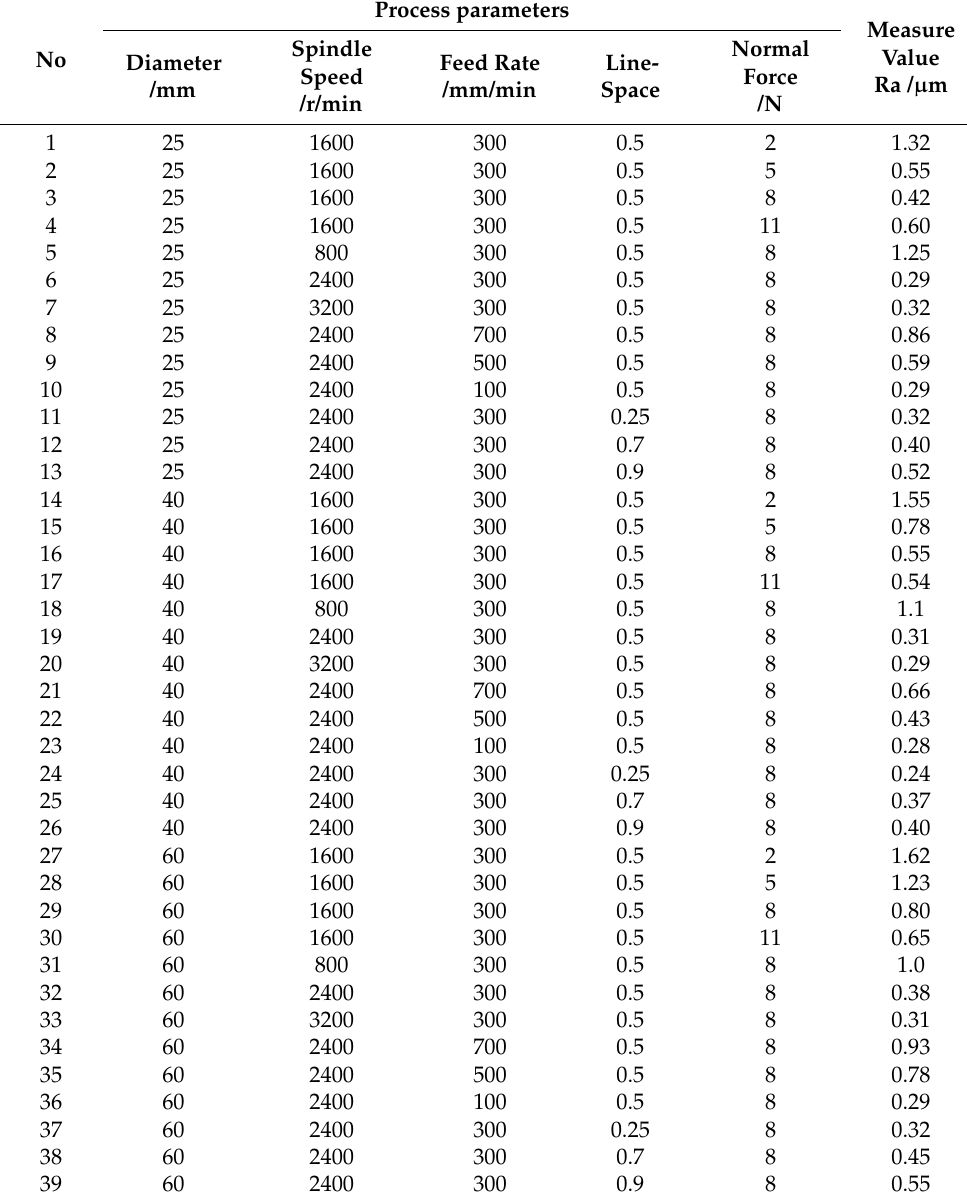
Table A1. The representative experimental results for training.